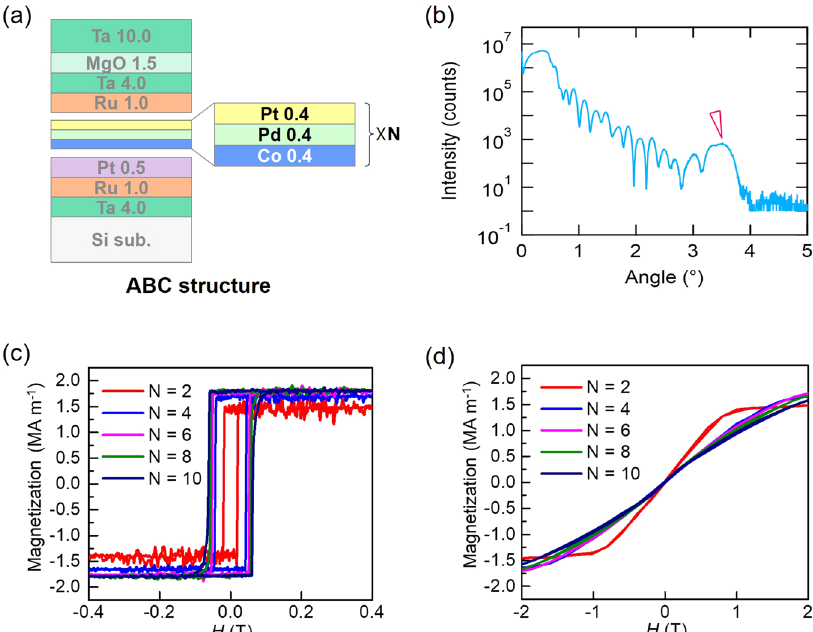
Fig. 5 Magnetic properties of the [Co/Pd/Pt] SLs. a A layer structure of the Co/Pd/Pt SLs. b XRR measurement result with the Co/Pd/Pt SL with N = 5. Magnetic hysteresis curves with c out-of-plane and d in-plane magnetic fi Augmented Plane Wave (FLAPW) code 21 . The MCA energy E MCA has been edge. Ti (5 nm)/Au (100nm) electrodes are de fi ned to make electrical contacts with μ m-scale Hall bars by photolithography and lift-off process. de fi ned in our calculation as the energy difference between the in- and